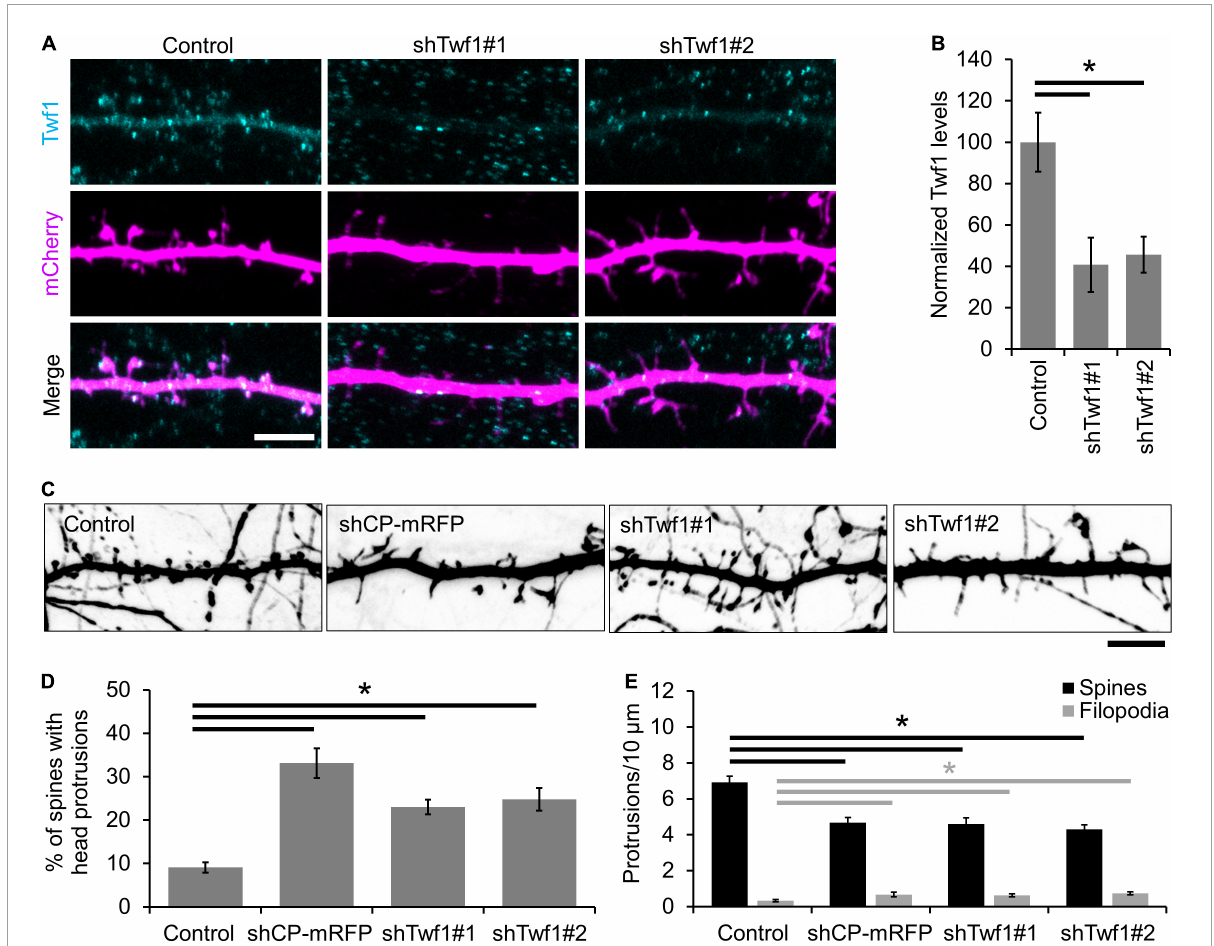
FIGURE3 Twinfilin-1 (Twf1) knockdown decreases spine density and increases filopodia density. (A) Representative images of control, shTwf1#1, or shTwf1#2 DIV21 hippocampal neurons expressing mCherry (magenta) and immunostained for endogenous Twf1 (cyan). Scale bar, 5 µ m. (B) Mean Twf1 fluorescence intensity relative to control cells. (C) Twf1 knockdown phenocopies capping protein (CP) knockdown in spines. Representative images of dendritic protrusions from neurons expressing shCP-mRFP, shTwf1#1, and shTwf1#2. Scale bar, 5 µ m. (D) Analysis showing the percentage of spines containing spine head protrusions. (E) Analysis of filopodia and spine density. N = 18 neurons for control, 10 neurons for shCP-mRFP, 16 neurons for Twf1#1, 19 neurons for Twf1#2. Error bars represent SEM. * P < 0.05; one-way ANOVA with Tukey’s post hoc